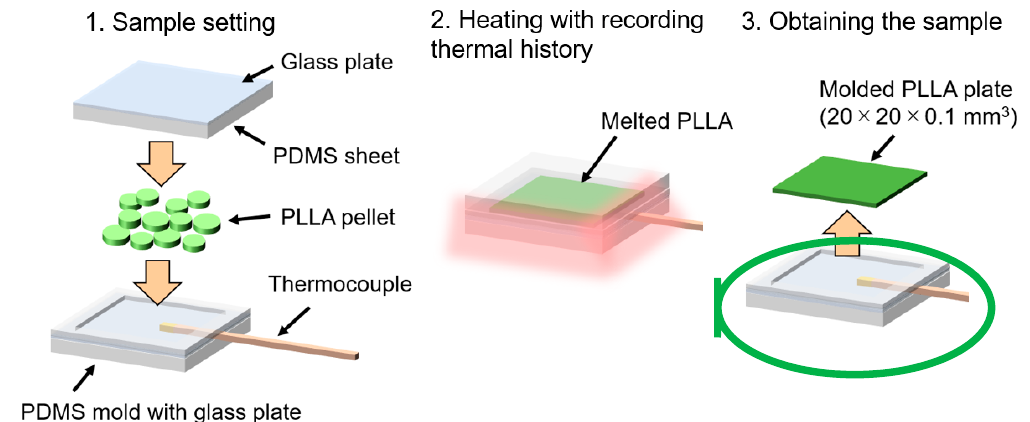
Figure 1. Schematic illustration of the poly (L-lactic acid) (PLLA) micromolding process with recording its thermal history using a poly(dimethylsiloxane) (PDMS) replica mold.